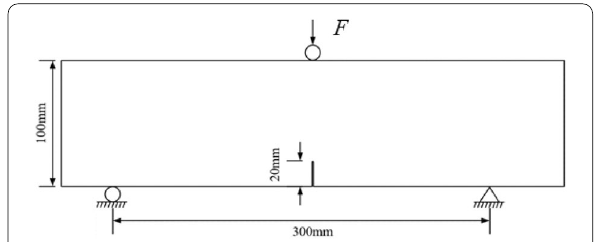
Fig. 9 Load and constraint conditions of numerical simulation